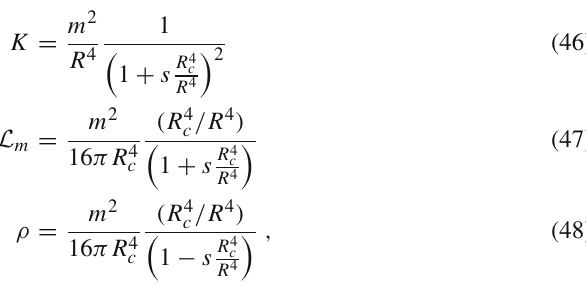
coordinates, (41) becomes